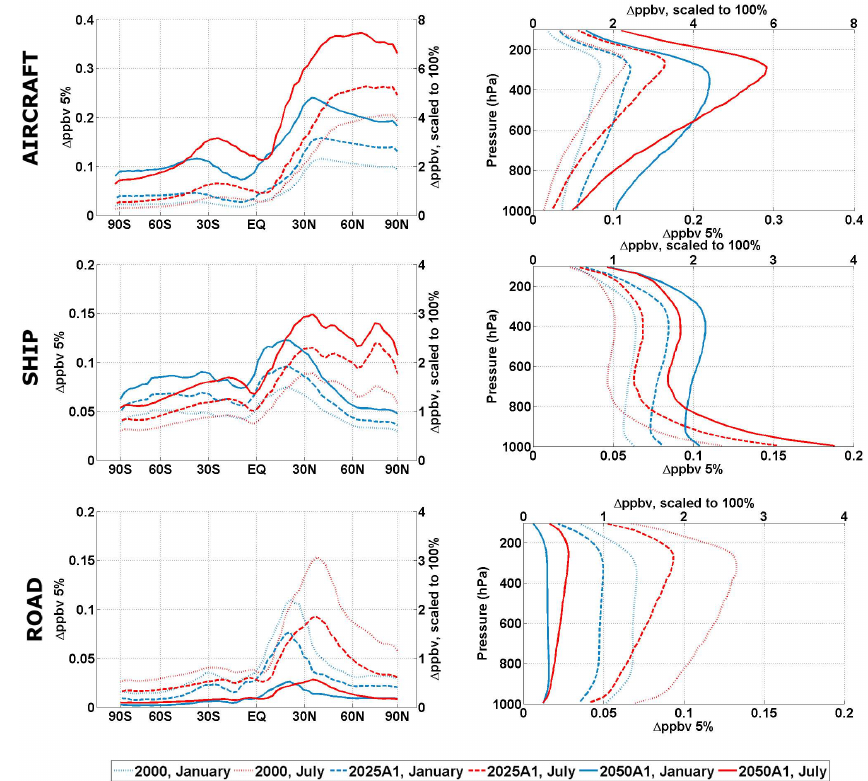
Fig. 3. Mean perturbations of ozone (ppbv) due to a 5% perturbation of aircraft emissions (top), ship emissions (middle), and road traffic emissions (bottom). The left column shows zonally averaged ozone perturbations in the upper troposphere (300–200hPa) for aircraft and in the lower troposphere ( > 800hPa) for ship and road traffic, while the right column shows the horizontally averaged perturbations in the Northern Hemisphere for all transport modes. The right y-axes in the left column and the top x-axes in the right column show the ozone perturbations when scaled from 5% to 100% by applying a factor of 20. Note that different scales have been used and that the scales have been reversed in order to show O 3 reductions, arising from a 5% decrease in emissions, as positive